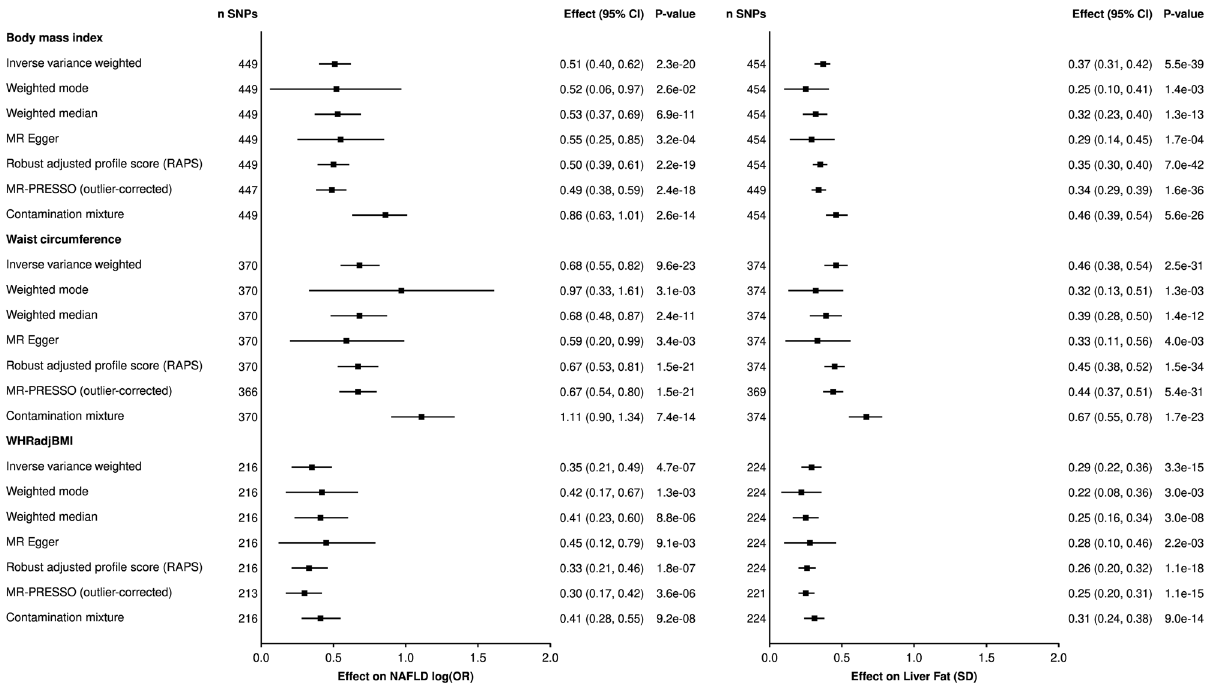
Fig. 1 Causal effect of genetically-predicted anthropometric traits on non-alcoholic fatty liver disease (NAFLD) and liver fat accumulation. Inverse- variance weighted Mendelian randomization (IVW-MR) and robust MR analyses were performed to assess the impact of one SD increase body mass index (BMI), waist circumference, and the waist-to-hip ratio adjusted for BMI on NAFLD and liver fat accumulation. Error bars are 95% con fi dence